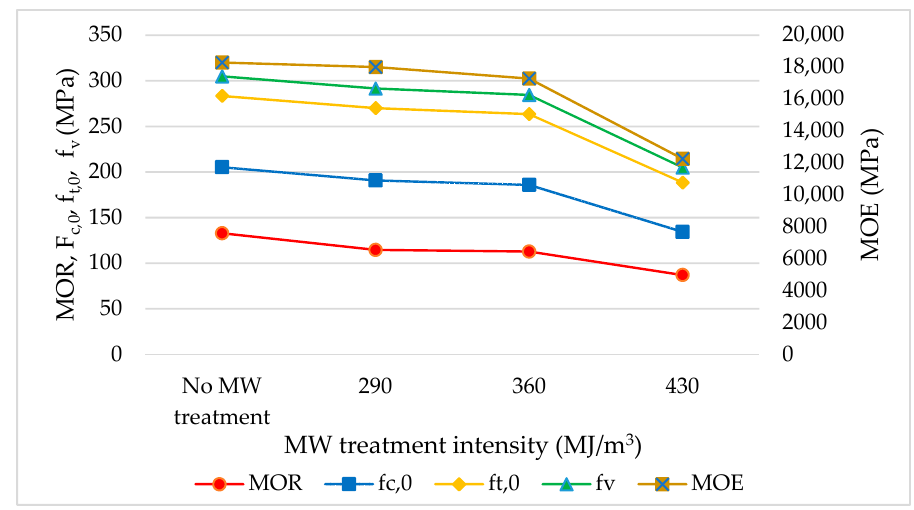
Figure 4. Relationship between mechanical properties and MW treatment intensity for 12% MC found by [7].